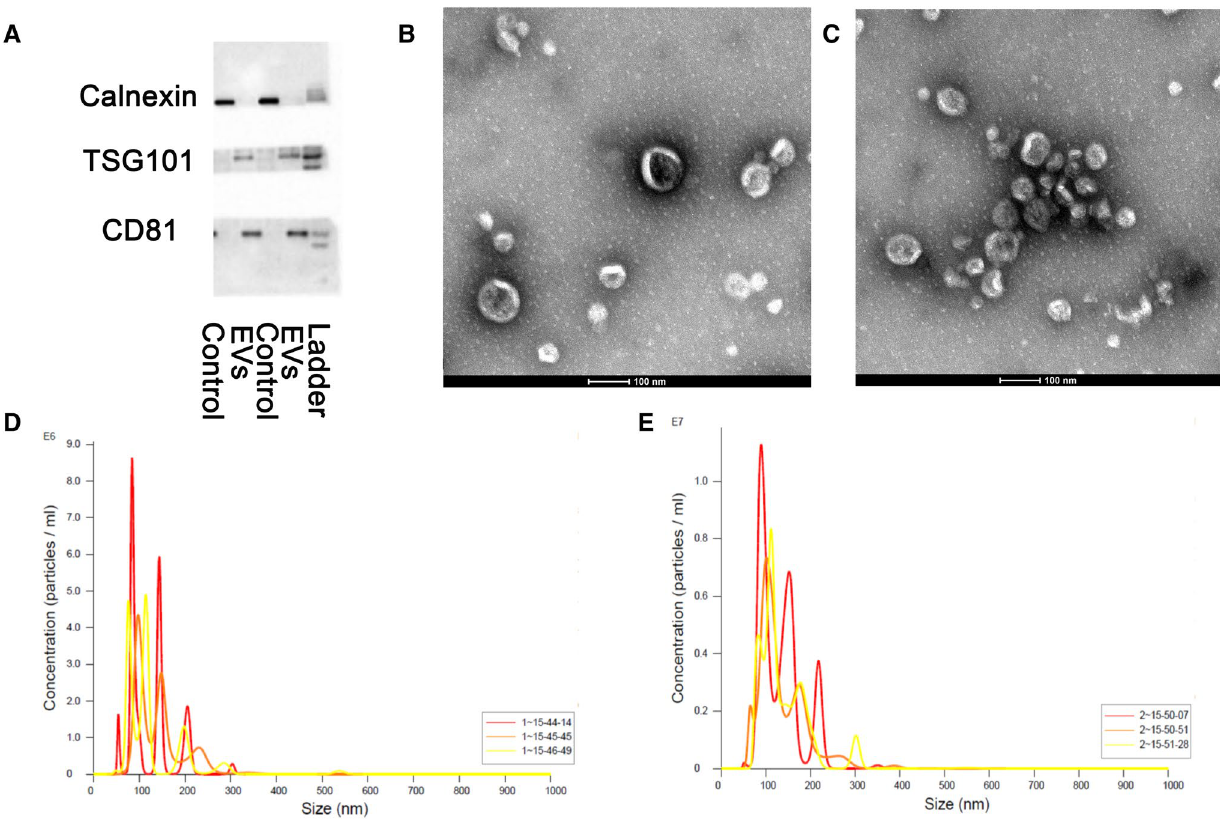
Fig. 1 Characterization of EVs. A Western blot of typical exosomal markers. B TEM of EVs derived from Hosepic cells. C TEM of EVs derived from ES-2 cells. D NTA of EVs derived from Hosepic cells. E NTA of EVs derived from ES-2